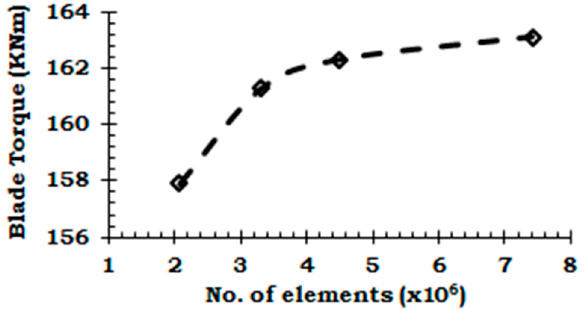
Figure 4. Variation of blade torque with grid density.